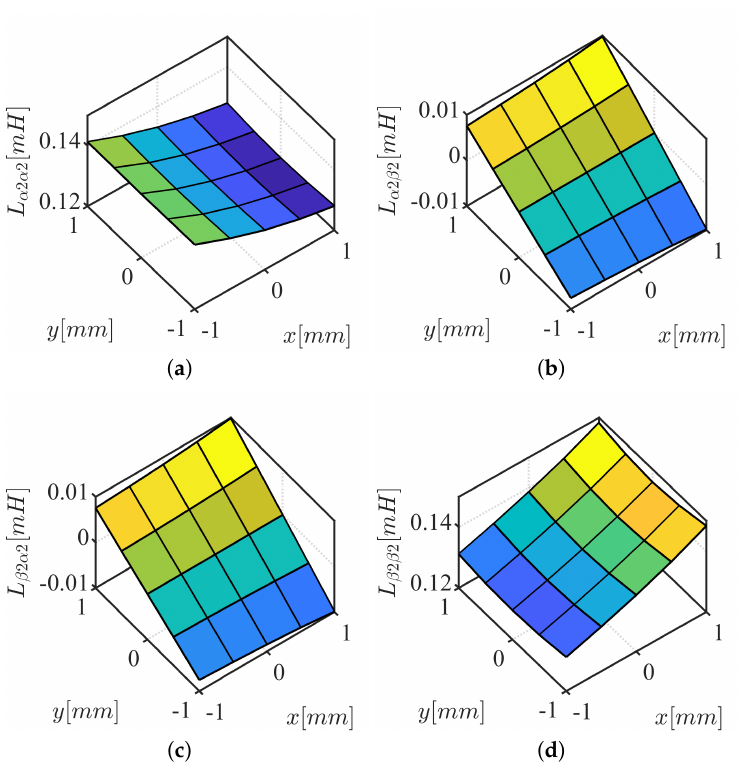
Figure 6. αβ 2 inductance results from FEA: ( a ) L α 2 α 2 ; ( b ) L α 2 β 2 ; ( c ) L β 2 α 2 ; ( d ) L β 2 β 2 .